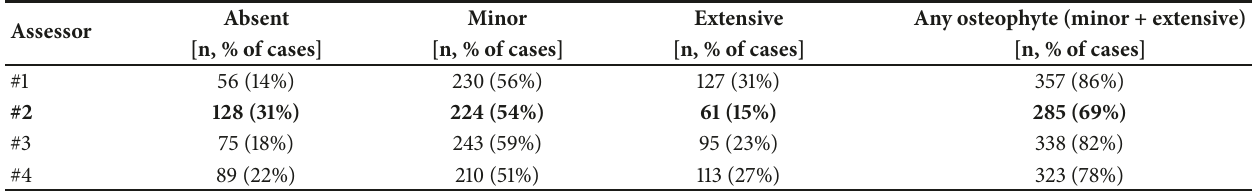
Table 2: Summary of ratings for presence of anterior femoral neck osteophyte, by assessor. Analysis was repeated with Rater #2 excluded due to divergence from the